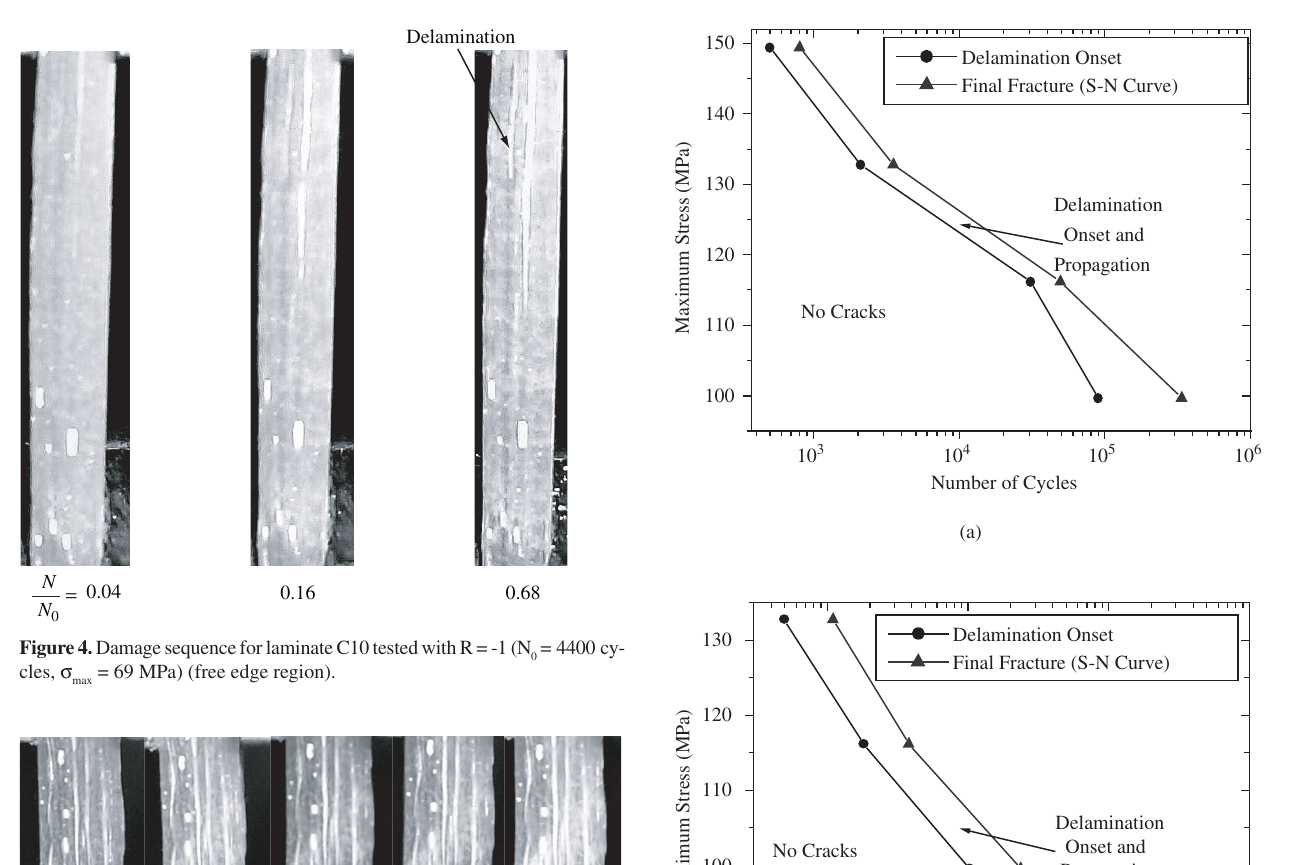
Figure 4. Damage sequence for laminate C10 tested with R = -1 (N cles, σ = 69 MPa) (free edge max